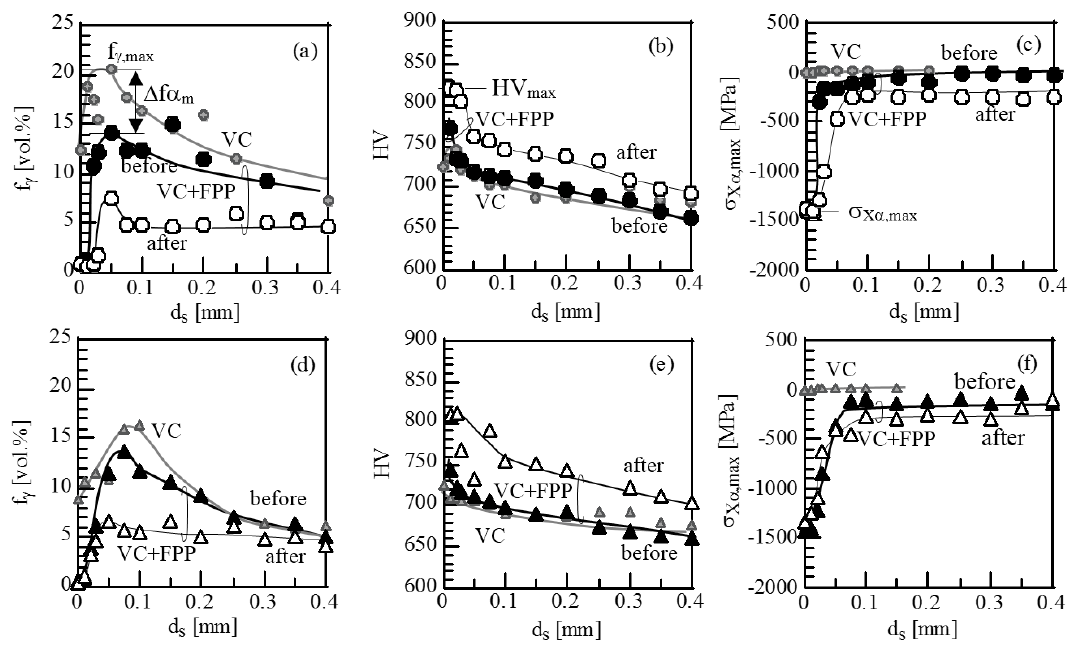
Figure 4. Variations of ( a , d ) volume fraction of retained austenite ( f γ ), ( b , e ) Vickers hardness (HV), and ( c , f ) residual stress ( σ X α ) as a function of depth from surface ( d s ) in ( a – c ) TM (